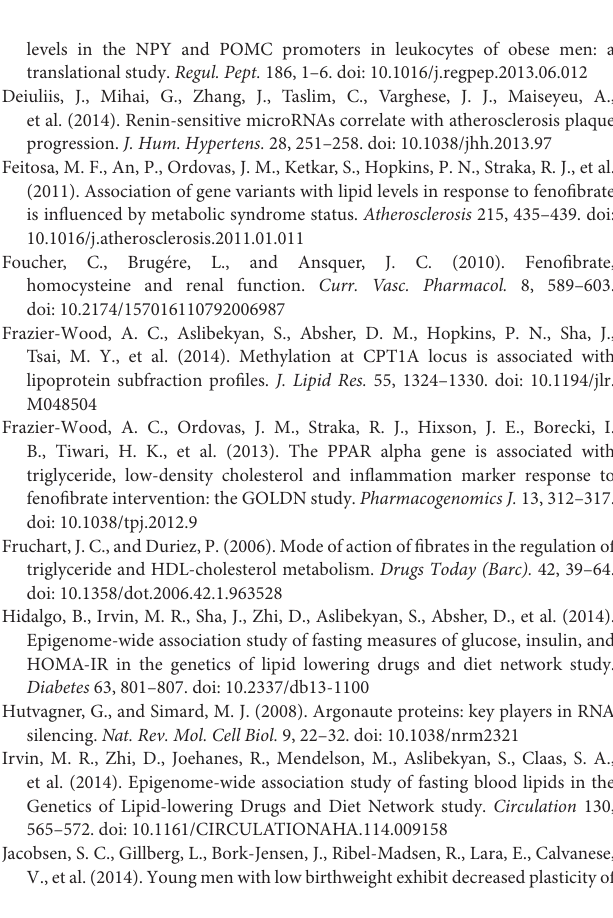
Supplemental Table 1 | Top five CpGs for each lipid showing change in DNA methylation for change in TG, HDLc, and LDLc profiles in the GOLDN study ( n = 443 ) after 3 weeks of daily fenofibrate (160 mg) with models additionally adjusted for alcohol, smoking and fat intake. Supplemental Table 2 | Variability in lipid response to fenofibrate explained by the methylation change variable for results presented in Table 2 in the